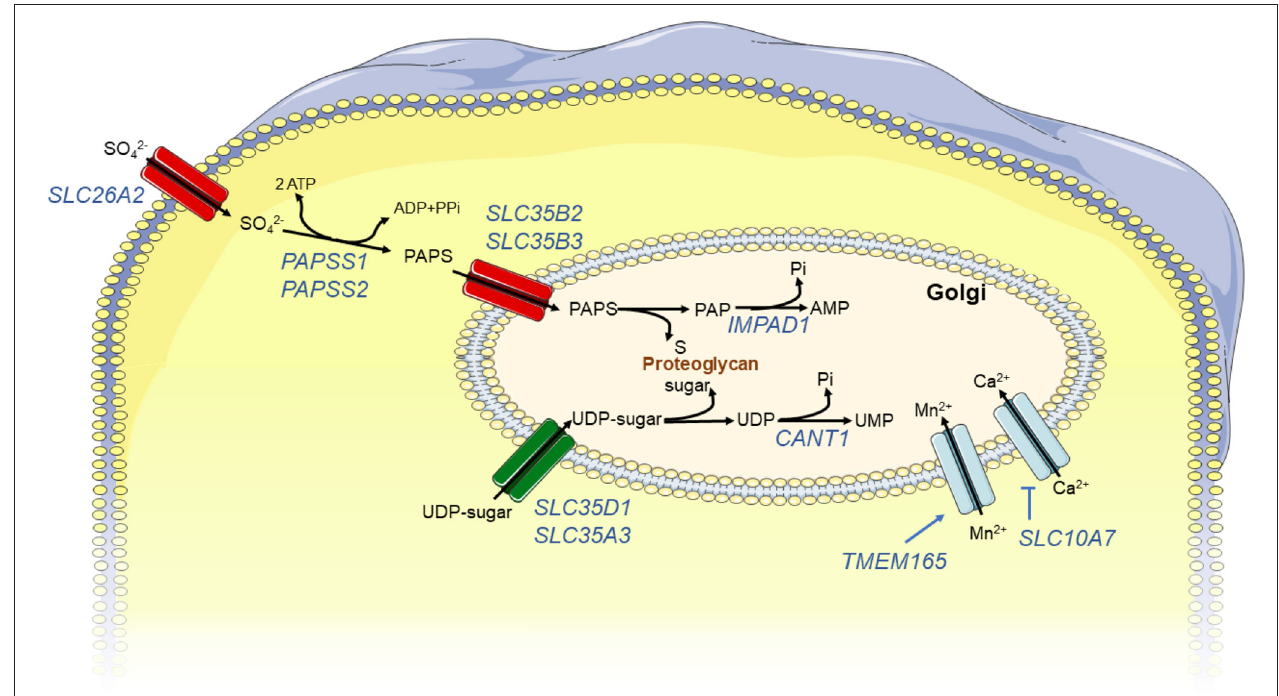
FIGURE 3 | Schematic view of enzymes or transporters associated with GAG synthesis: GAG synthesis requires specific substrates, nucleotide sugars used by glycosyltransferases, and PAPS used by sulfotransferases. Nucleotide sugars and PAPS are synthetized in cytoplasm and are transported in Golgi by specific carriers. Then, glycosyltransferase and sulfotransferase activities produce by-products, UDP and PAP, respectively, that have to be degraded to avoid inhibition of catalytic activity of these enzymes via feedback mechanisms. Finally, to assure correct activity of glycosyltransferases, Golgi environment, and in particular its concentration in divalent ions, has to be tightly regulated via import/export of these ions. Enzymes, proteins, or transporters implicated in these processes are indicated in